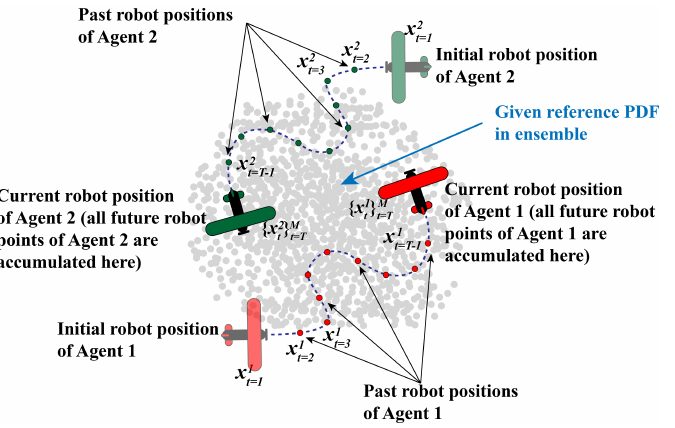
Figure 3. Schematic of UAV points with their relative locations at different time steps for two agents. Initial points: { x k